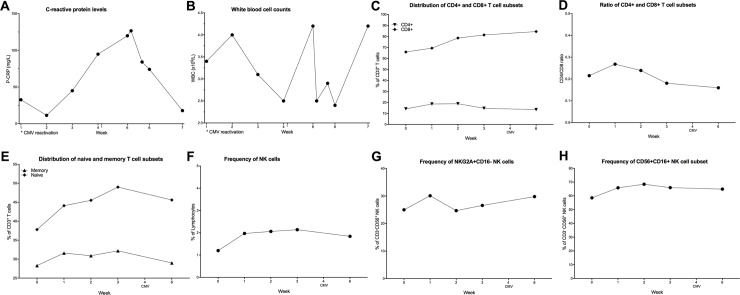
Clinical and immunological parameters from a 65y male patient with CMV reactivation during dara treatment.(A-B): The laboratory parameters CRP (A) and WBC at admission during the Dara treatment and CMV reactivation are shown. (C-H) Peripheral blood samples were collected from patients throughout the Dara treatment. PBMCs were stained with lymphoid lineage markers and analyzed by flow cytometry, as described in experimental procedures. Frequencies of T cell and NK cells subsets are depicted. (C) percentages of CD8+ and CD4+ T cells and (D) CD4/CD8 ratio during Dara treatment (E) distribution of memory (CD45RA-CD45RO+) and naïve (CD45RA+CD45RO-) T cell subpopulation. In (F), total CD3-CD56+ NK cells as the percentage of lymphocytes and (G) CD56+CD16-NKG2A+ NK cells as the percentage of CD3-CD56+ NK cells are shown. (H) shows frequency of CD56+CD16- as the percentage of total CD3-CD56+ NK cells.